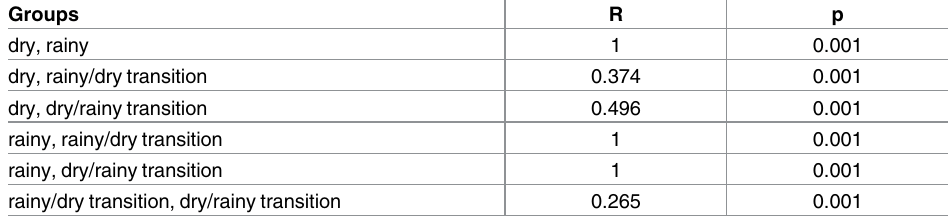
Table 2. ANOSIM with environmental data across hydrocycles, in two Caatinga areas, namely the Serra da Capivara and Serra das Confus õ es National Parks, state of Piauı´, Brazil. Groups